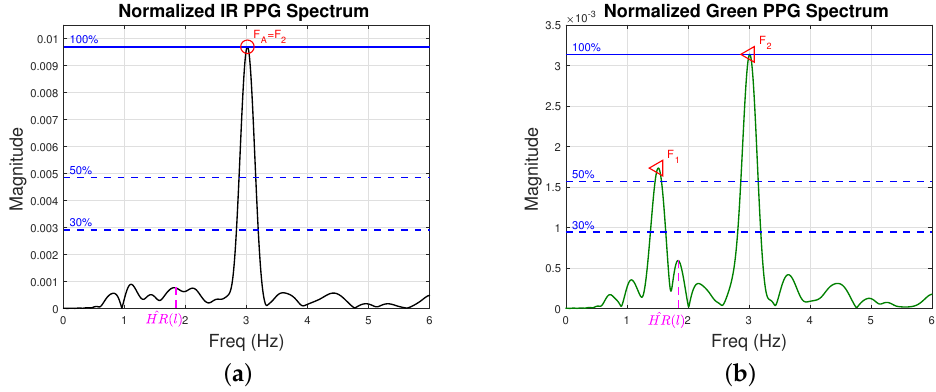
Figure 8. IR and green spectra from participant 10 around 136 s. We show in magenta the heart rate estimate at time step l , ˆ HR ( l ) . ( a ) Frequency spectrum of participant 10’s IR PPG signal. The red circle labeled F A = F 2 represent the dominant noise frequency. ( b ) Frequency spectrum of participant 10’s green PPG signal around time 136 s. The two red triangles labeled F 1 and F 2 represent high-intensity harmonically related frequencies. Note that the frequency F A from ( a ) is the same of the frequency F 2 from subplot ( b ). Both F 1 and F A = F 2 are put into N noise .